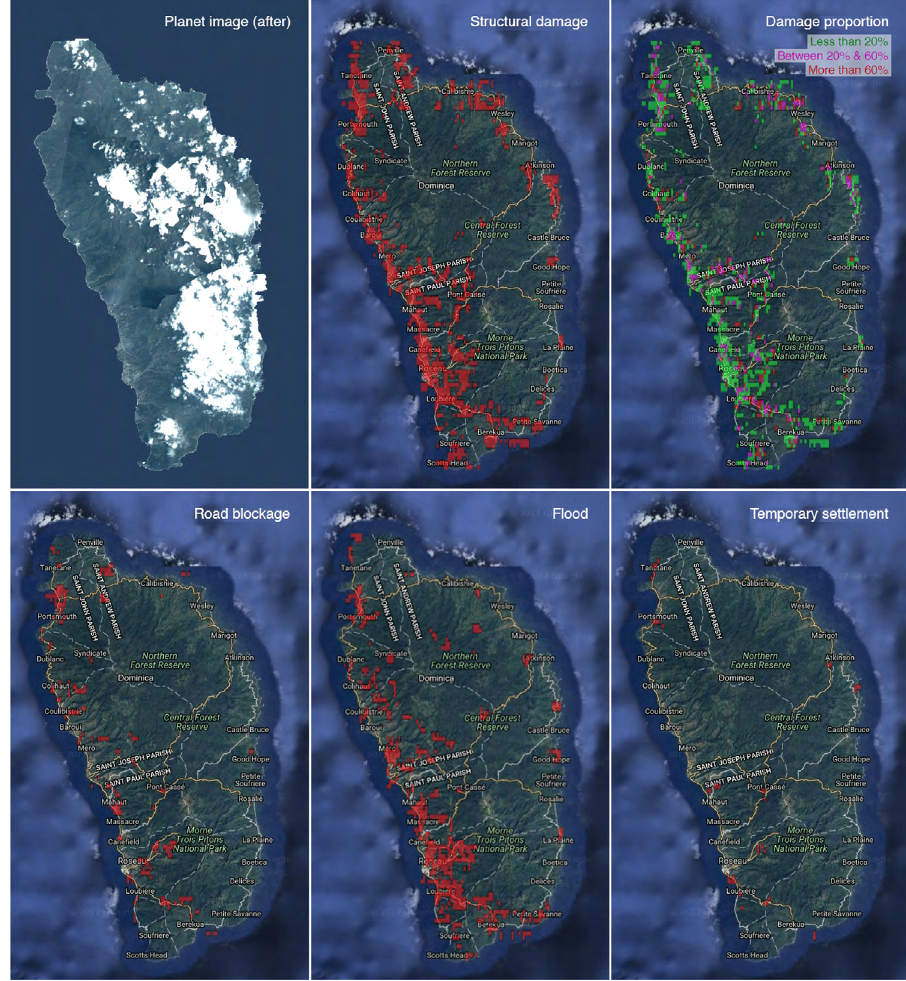
Figure 2 Heat maps for labeled features in Dominica following Hurricane Maria in 2017. Web-based maps may be zoomed in to show further detail. Satellite imagery credit: Planet Team (2017) License: